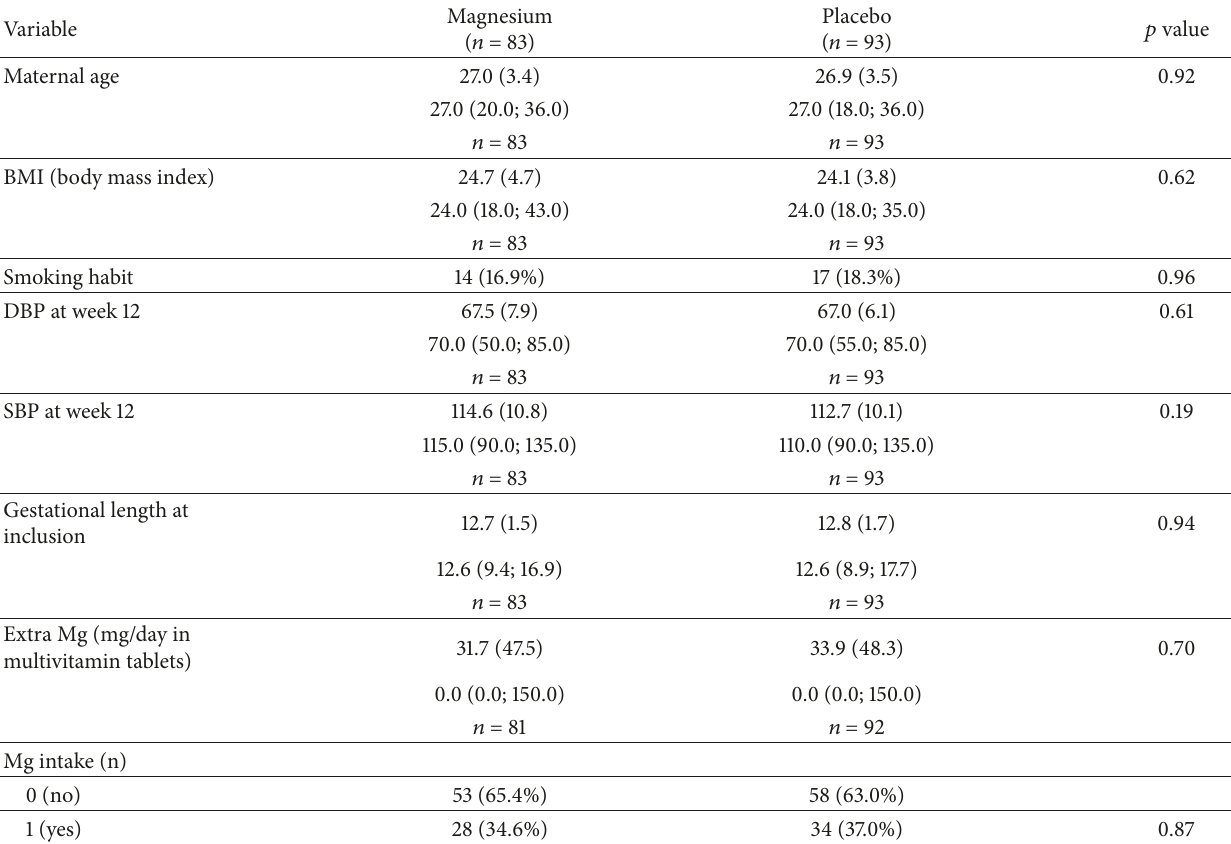
Table 1: Baseline data